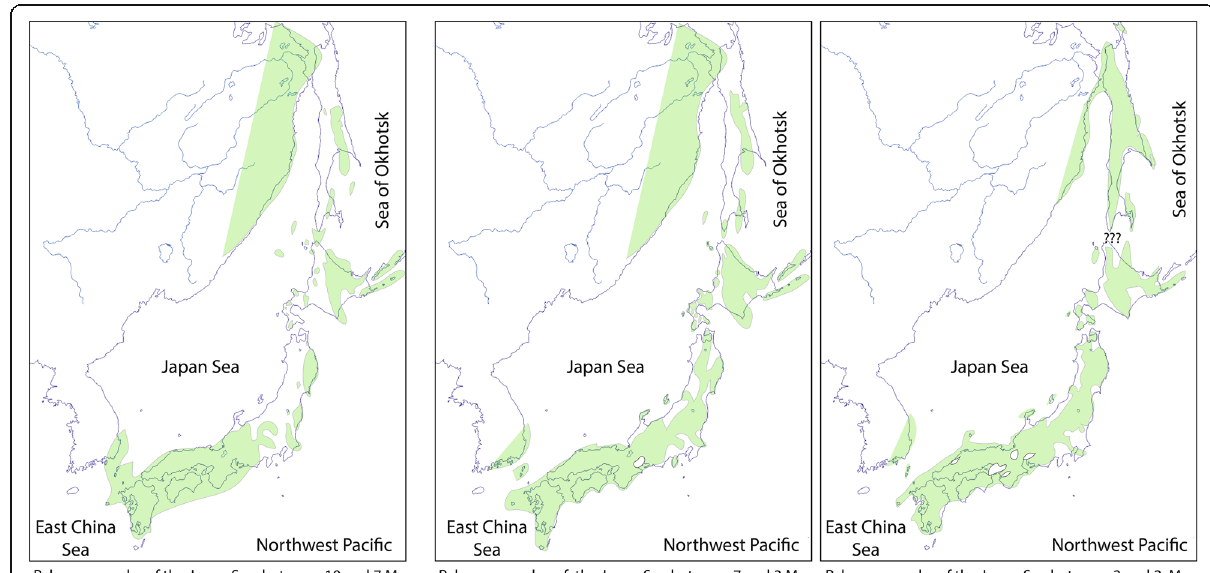
Fig. 2 Evolution of the Japan Sea since 10.5 Ma and its paleomaps (based on Fukusawa 1988; Fujii et al. 1992; Iijima and Tada 1990; Sato 1994; Kano et al. 1991; Kharakhinov 2010; Kobayashi and Tateishi 1992; Kosaka et al. 1992; Sagayama, 2002; Yahata 2002; Yoshida et al. 2013). The base lines of the coasts and hydrography came from